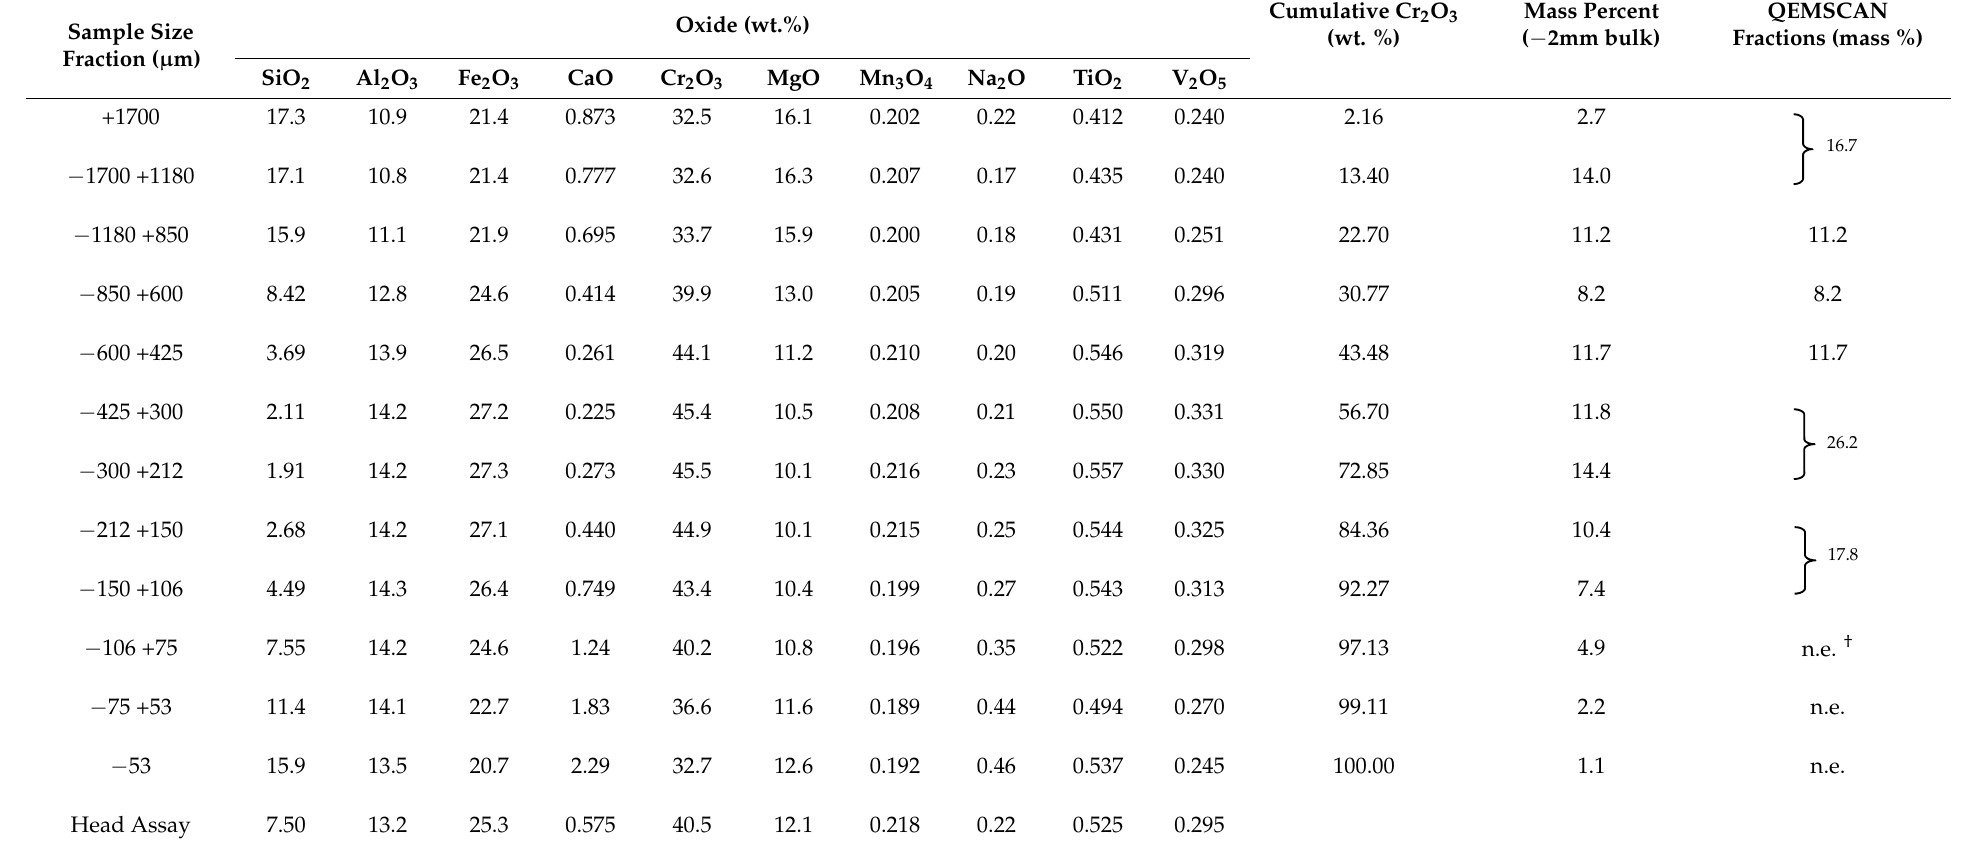
Table 1. Chemical assay and mass data for the initial twelve size fractions, plus a list of size fractions that were combined and analyzed via QEMSCAN.